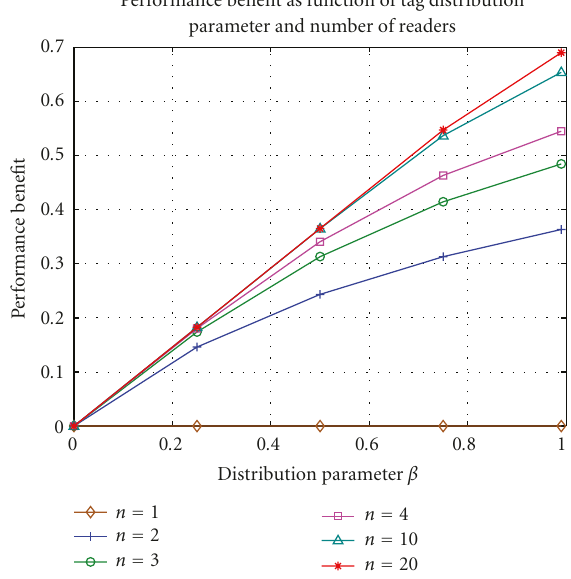
Figure 10: Performance gain through numerical evaluation for di ff erent values of n as a function of β with α = 0